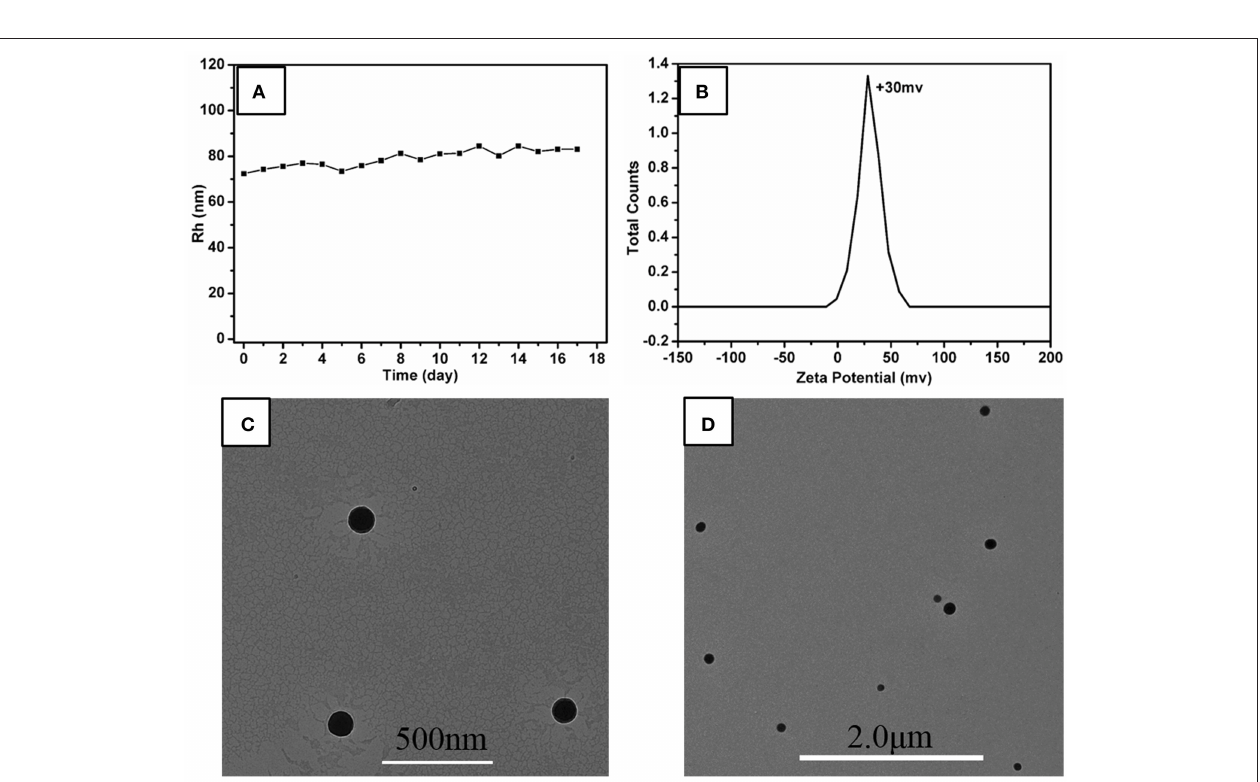
FIGURE 3 | (A) Change of hydrodynamic radii ( R h ) of P5A-CrMo 6 in water solution with time. Charge ratio of P5A-CrMo 6 is 10:10. The concentration of P5A-CrMo 6 is 0.05 mg/mL. (B) Zeta potential of the P5A-CrMo 6 self-assemblies with charge ratio 10:10 at 0.05 mg/mL in water solution. (C) TEM image of the self-assemblies immediately after mixed together. (D) TEM images of self-assemblies after 17th